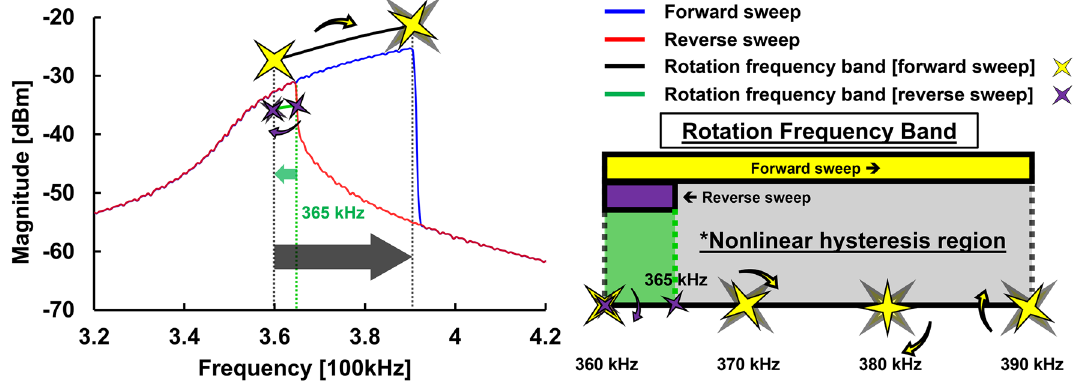
Figure 4. Forward and reverse frequency sweeps of the resonator: To study the rotation frequency band of the resonator, forward and reverse sweeps were performed to identify the rotation start frequency as well as the rotation stop frequency. The nonlinear rotation was observed from 360 to 390 kHz during the forward sweep. On the other hand, the nonlinear rotation was observed from 365 to 360 kHz during the reverse that the direction of the rotational motion is counterclockwise because the real-time image presented in DHM is mirror symmetric. To further identify the rotation frequency band, we examine the measurement results during the forward sweep in detail. As shown in the video, in the beginning, the mechanical motion of the resonator is in normal (1,1) mode, even though the amplitude of the driving signal (triggered voltage of 1.7 V) is high enough to drive the resonator into the nonlinear rotation as mentioned before. Once the sweep frequency reaches 360 kHz, the nodal line of the resonator starts to rotate until it reaches the non-resonant frequency of 390 kHz. Therefore, there is not only a threshold voltage but also a specific rotation frequency band to trigger the rotating nodal line of the resonator. To further study the rotation frequency band of the soft PZT-based resonator, forward and reverse frequency sweeps of the resonator were performed through the integrated inner electrode and measured using the SA shown in Fig. 4. During the forward sweep, the nonlinear mechanical rotation was observed from 360 to 390 kHz. In contrast, the nodal line of the resonator starts to rotate at 365 kHz and stops at 360 kHz during the reverse sweep. Therefore, a specific rotation frequency band from 360 to 390 kHz is identified by applying an actuated chirp signal of 3 V through the integrated inner electrode of the resonator. It is worth mentioning that the frequency band of 365 kHz to 390 kHz, usually called the nonlinear hysteresis region caused by the strong stiffness hardening effect, features the nonlinear rotation motion during the forward sweep. On the contrary, during the reverse sweep, the resonator shows normal motion, i.e., no rotation, in the nonlinear hysteresis region. Energy transfer is one of the common behaviors in nonlinear phenomena. To explore whether energy is transferred inside the resonator through the change from the case of a fixed nodal line to the case of a rotating nodal line, a simple electrical experiment setup via a SA in Max-hold mode was performed to record the energy transfer path for validation as shown in Fig. 5. The mechanical rotation was triggered by a chirp signal with a threshold voltage of 1.7 V and measured by a SA. Furthermore, to identify the onset of the rotation, the resona- tor was driven with a single-tone drive signal of 360 kHz at the onset frequency of the rotation frequency band and measured in a SA for comparison. As shown in Figs. 3 and 5, the increment in the output voltage at the driving frequency (1.7 V, 360 kHz) and its integer frequencies is strong evidence of the change of the nonlinear state (from the case of fixed nodal line to the case of rotating nodal line). According to measurement results, the apparent change in the slope of magnitude at higher-order harmonics indicates that energy transfer takes place